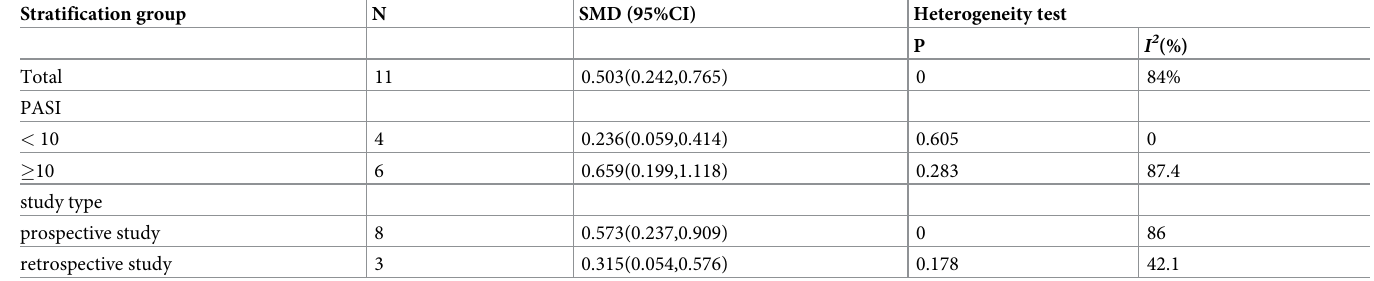
Table 2. Subgroup analysis of MPV in